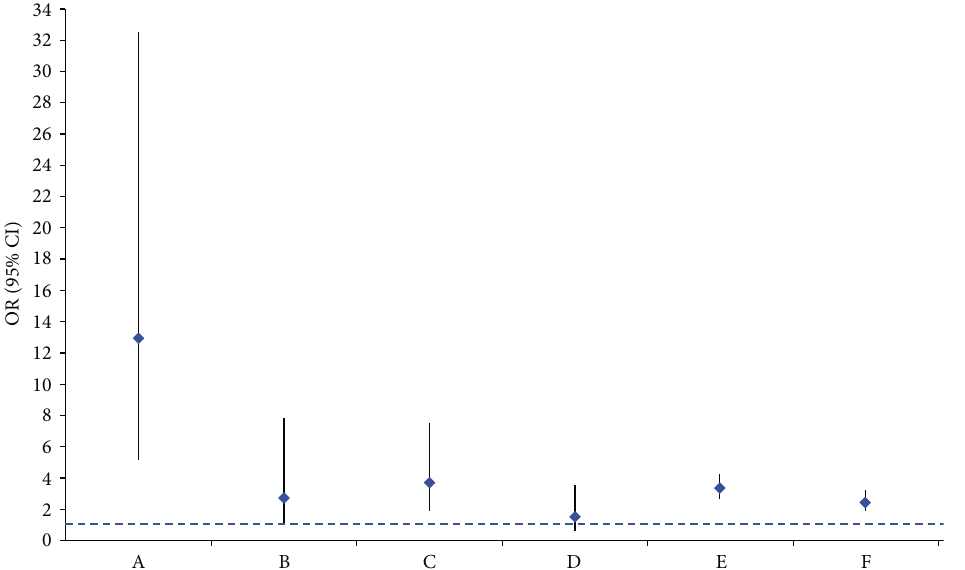
Figure 3: Association estimates between pancreatitis and in fl ammatory bowel disease. (a) The risk of Crohn disease in the patients with chronic pancreatitis; (b) the risk of ulcerative colitis in the patients with chronic pancreatitis; (c) the risk of Crohn disease in the patients with acute pancreatitis; (d) the risk of ulcerative colitis in the patients with acute pancreatitis; (e) the risk of acute pancreatitis in the patients with Crohn disease; (f) the risk of acute pancreatitis in the patients with ulcerative